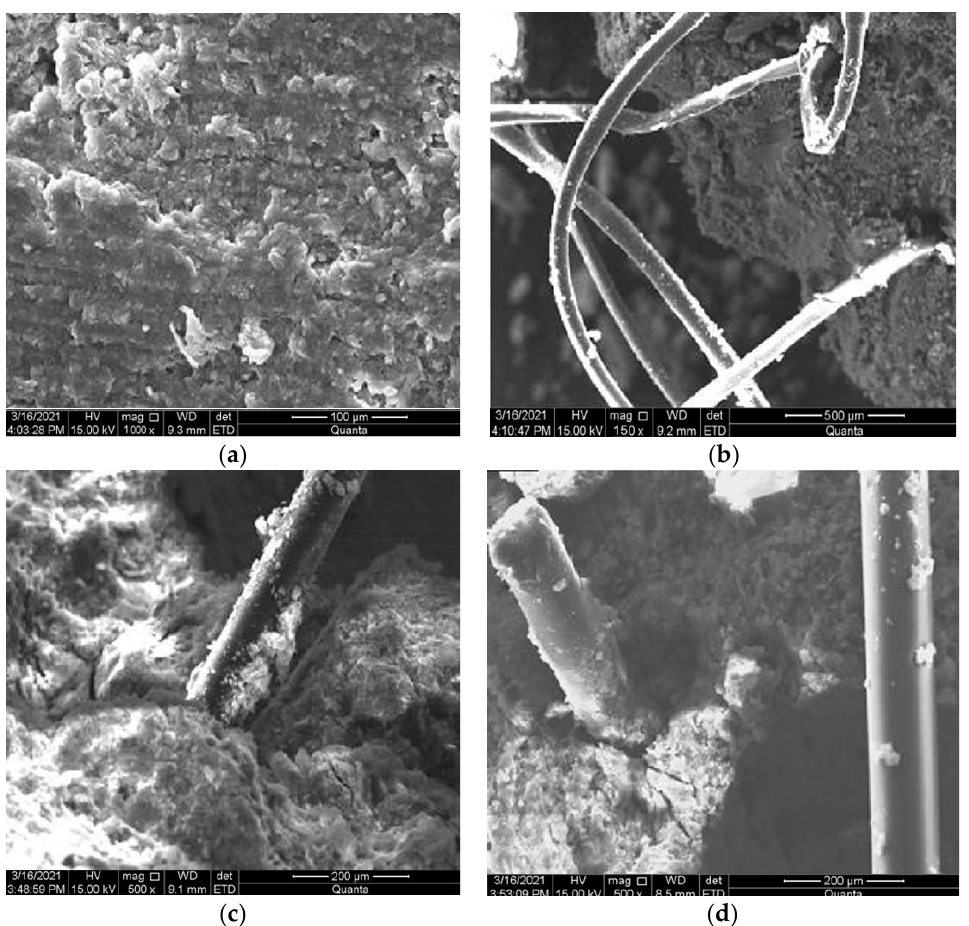
Figure 11. SEM chart of fiber cement soil. ( a ) fiber content 0%; ( b ) fiber content 0.1%; ( c ) fiber content 0.2%; ( d ) fiber content 0.4%.